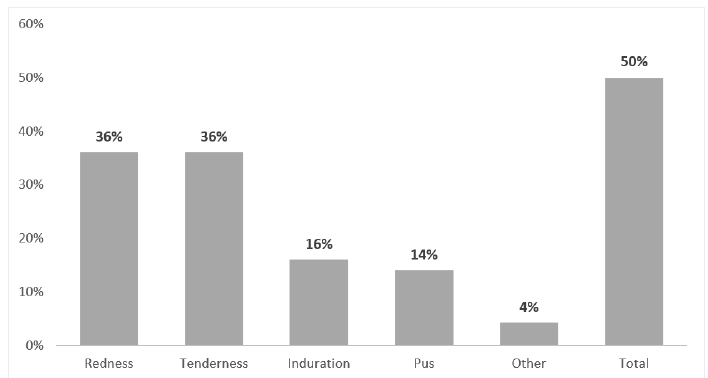
Figure 2. Reported central venous catheter (CVC) insertion abnormalities in patients receiving total parenteral nutrition at time of S. aureus bacteremia.